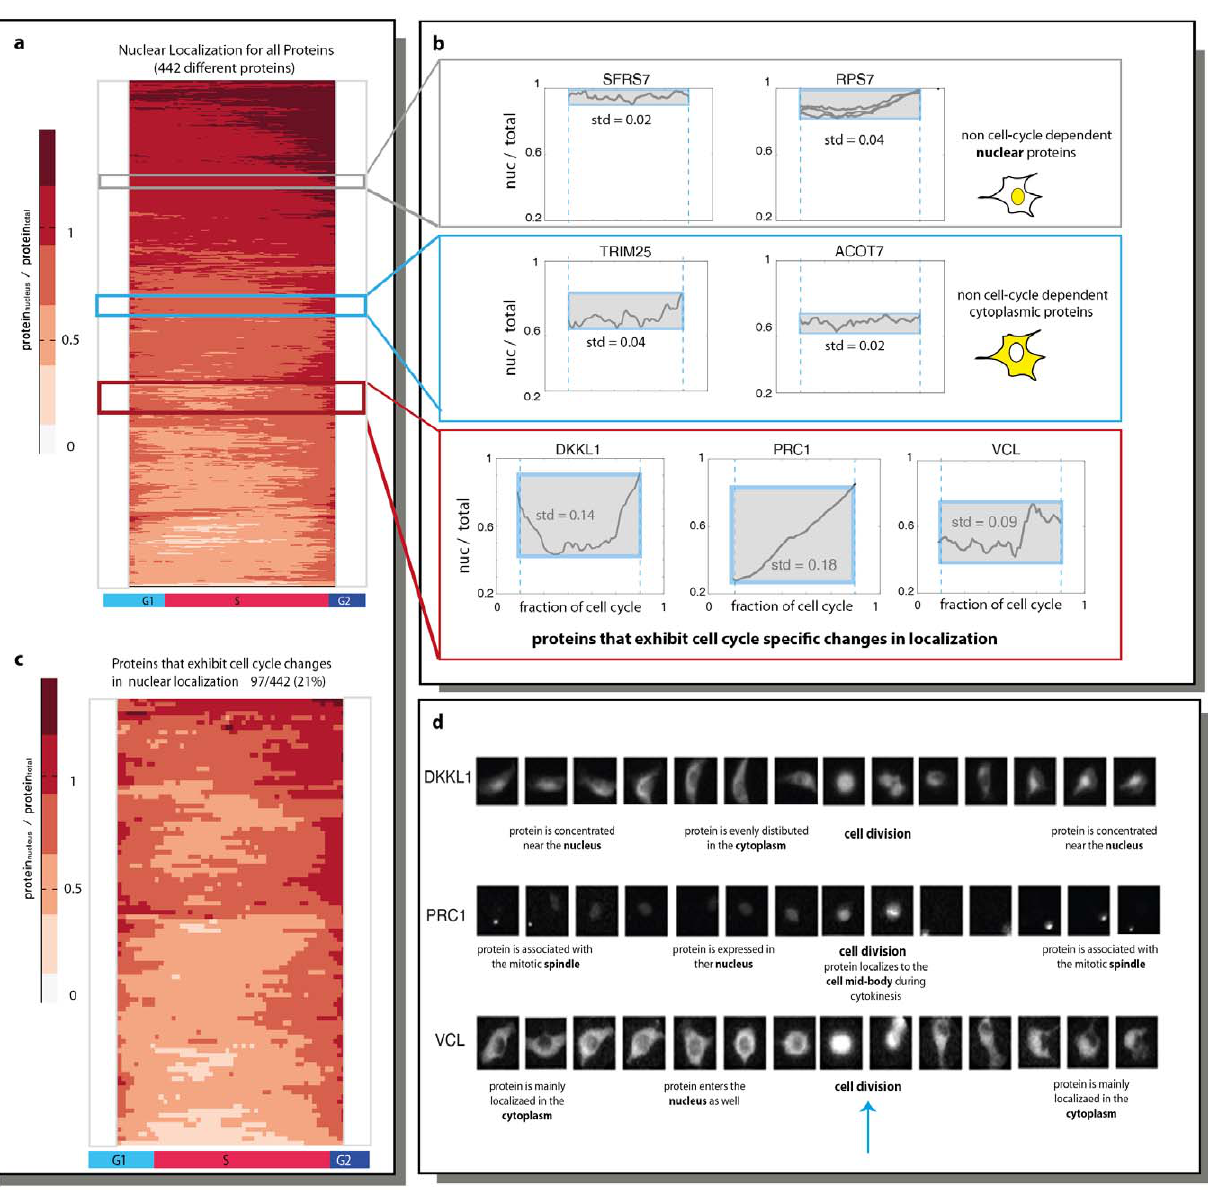
Figure 3. Cell cycle dependence of nuclear localization. (A) The ratio between the fluorescence in the nucleus versus the total fluorescence is shown for 442 proteins as a function of fraction of cell cycle. Due to difficulties with discrimination between the nucleus and the cytoplasm near mitosis, we excluded the values in the first and last 2 hours of the cell cycle. (B) Examples for nuclear, cytoplasmic proteins and proteins that changes localization in a cell cycle specific manner are shown. (B) Profiles of the nuclear ratio of the 97 cycling proteins are shown. (D) Examples of single cells along the cell cycle are shown for three clones that were found to change their localization during the cell cycle. Blue arrow indicates time of cell